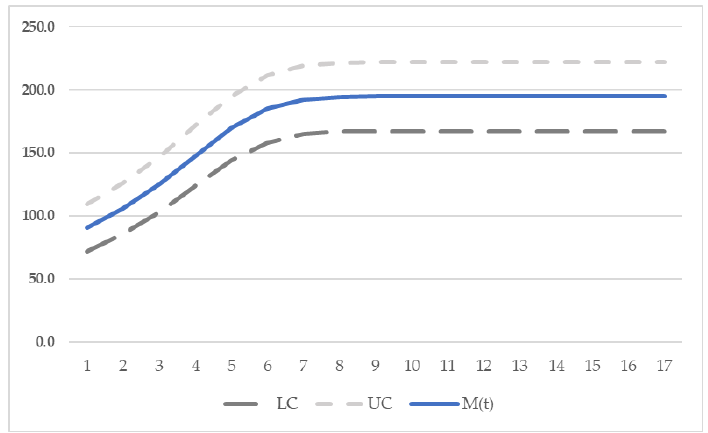
Figure 8. Confidence interval of proposed model for dataset 2.